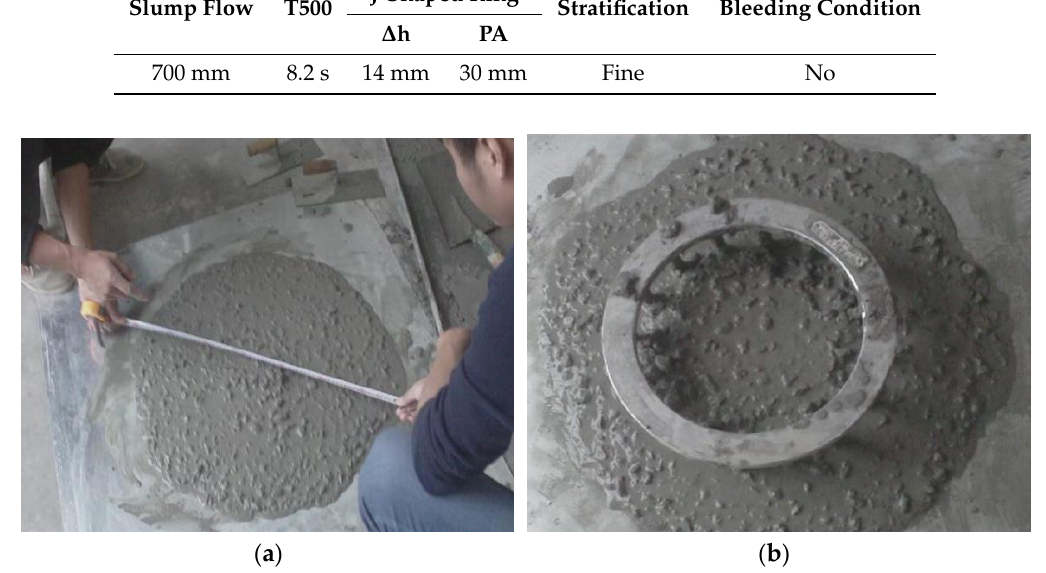
Figure 4. Effect of steel slag sand on the basic workability of SSCC after mix proportion adjustment. ( a ) slump flow (SF) and T500; ( b ) passing ability (PA) and Δh. The test results show that when VPS = 20%, due to the small amount of steel slag sand, it has little effect on the fluidity and filling performance of the fresh mixture, and the performance of